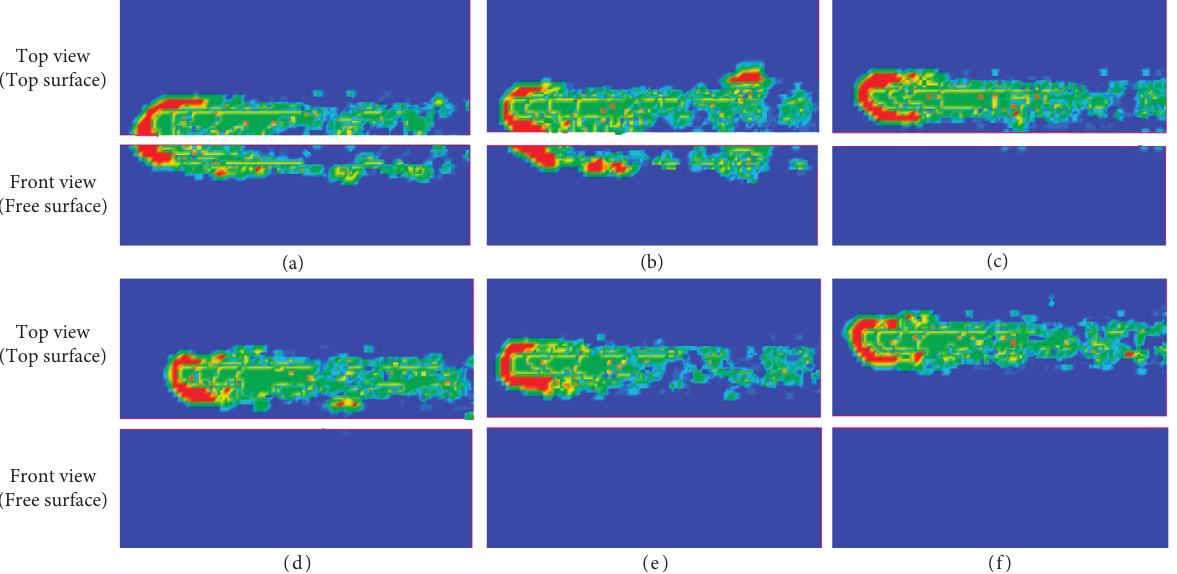
Figure 12: Damage nephogram of rock cut by the sawblade with different distance from rock free surface.